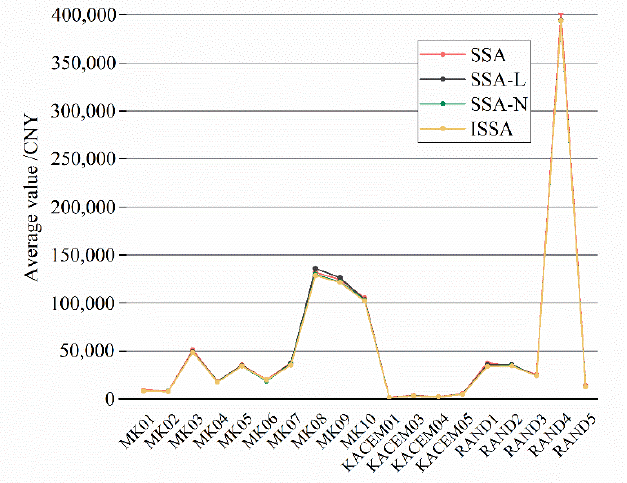
Figure 7. Comparison of average values of four algorithms for 19 instances.